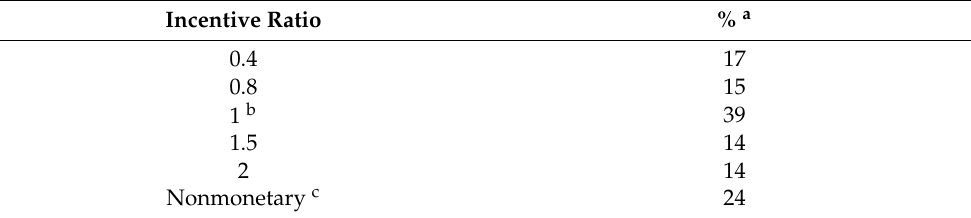
Table 5. Percentages of incentives assigned to study participants from 77 participating farmers’ markets. Incentive Ratio